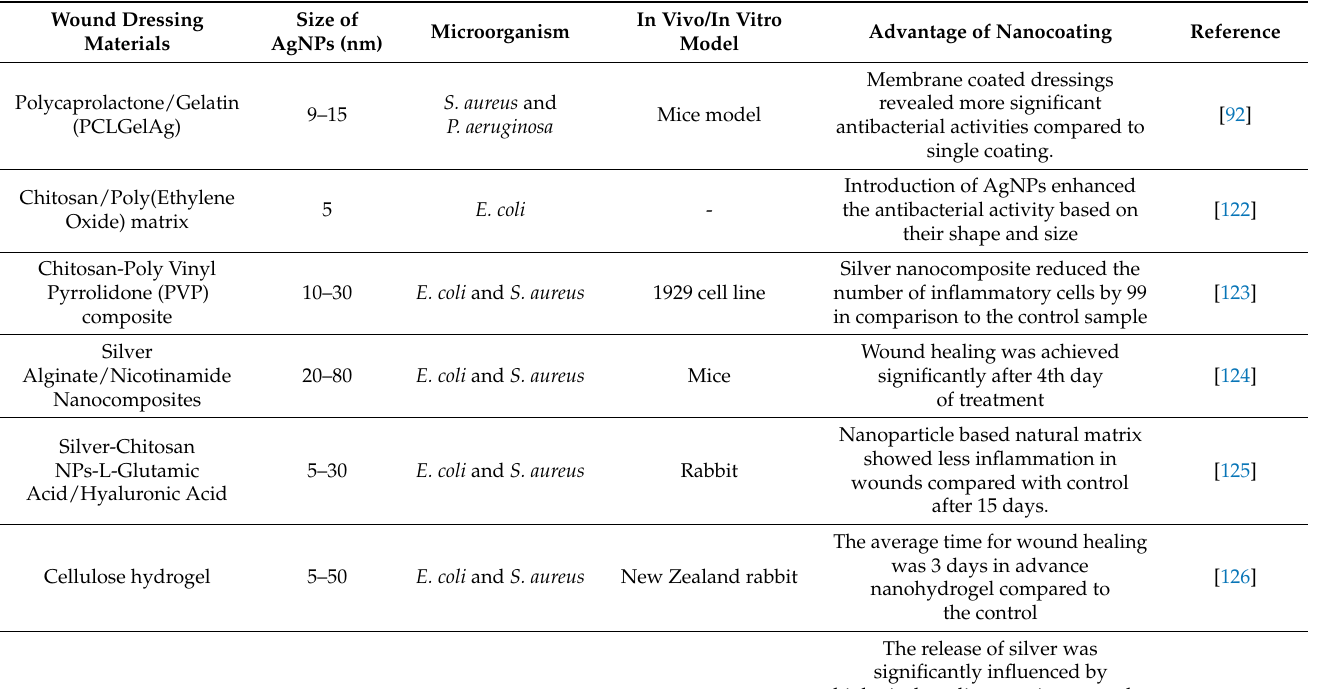
Table 2. An overview of available wound dressing materials fabricated with AgNPs and their